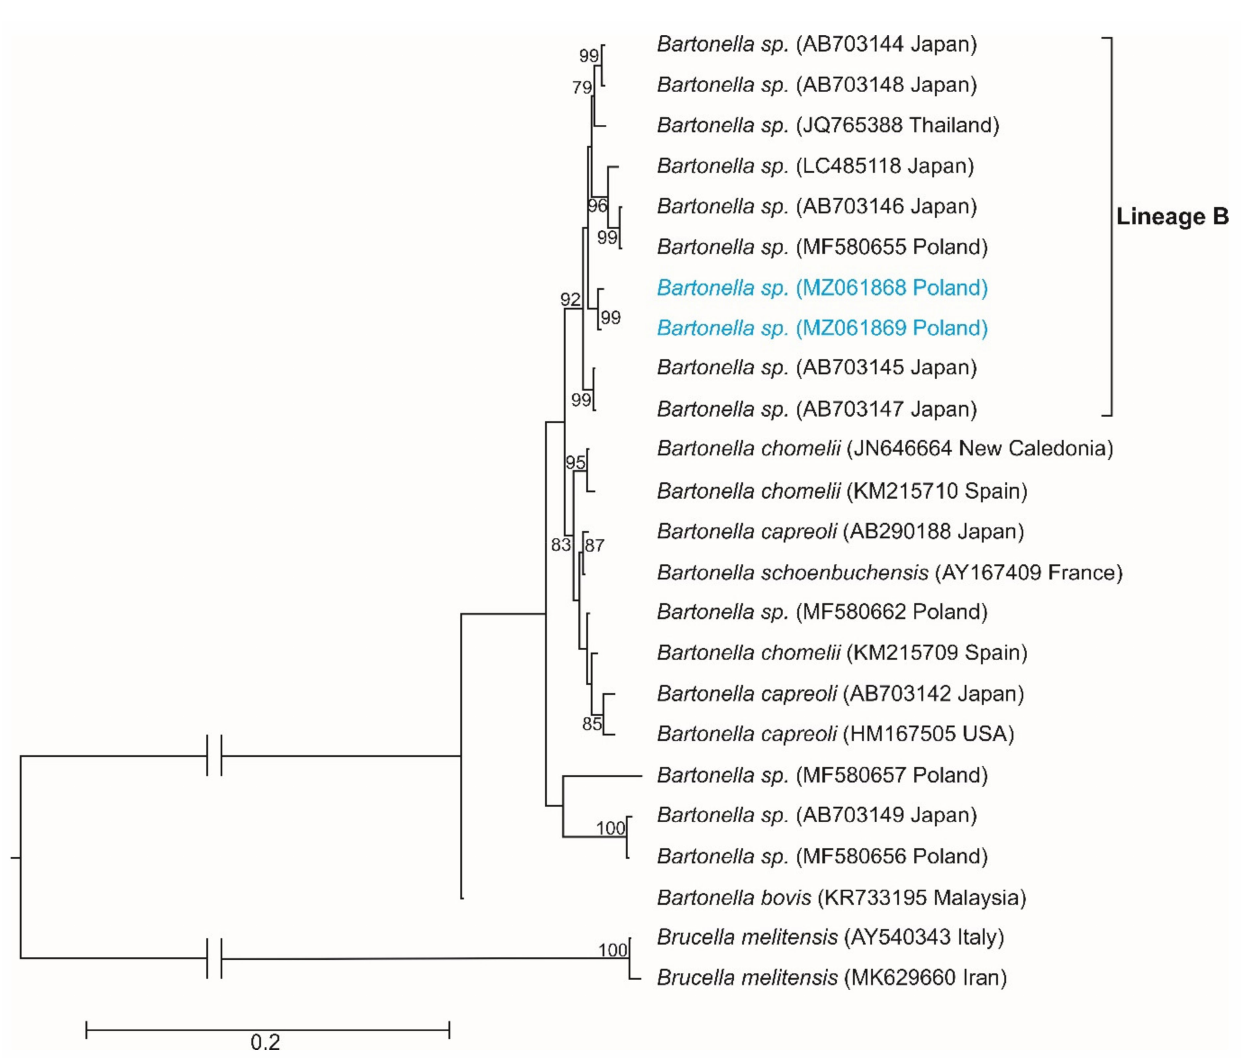
Figure 2. Maximum-likelihood topology computed with the GTR+I+G model of substitution evolution, representing the phylogenetic relationships among the sequences of the rpo B gene for RNA polymerase beta-subunit found in Bartonella sp. Numbers listed at the nodes represent the percent support for the node from 1000 bootstrap replicates. The ML tree has been rooted with sequences of Brucella melitenis , a microorganism closely related with Bartonella sp., as they together belong to the same order, Hyphomicrobiales. The haplotypes of Bartonella sp. found in this study are marked in blue. Lineage B, according to Sato et al.